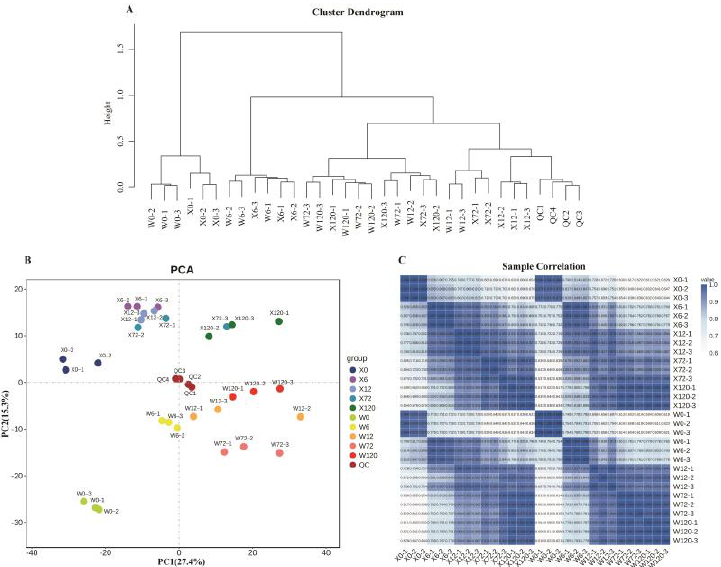
Figure 3. Sample quality control diagram, ( A ): Hierarchical clustering of 30 samples; ( B ): 2D map of principal component analysis; ( C ): Pearson’s correlation heatmap of 30 samples.